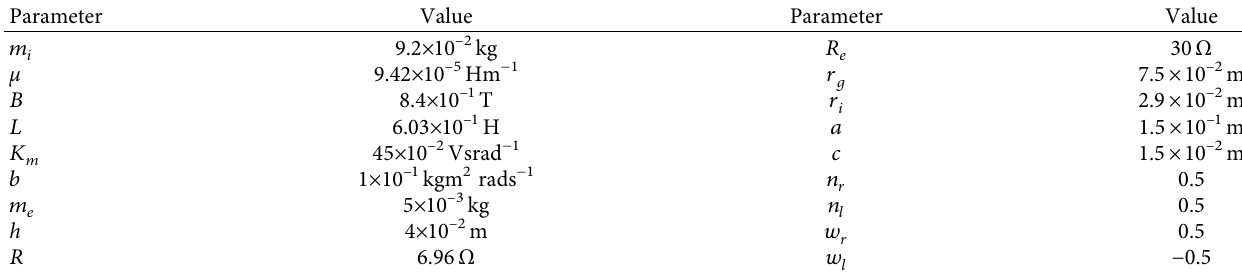
Table 2: Parameters of electricity generators.